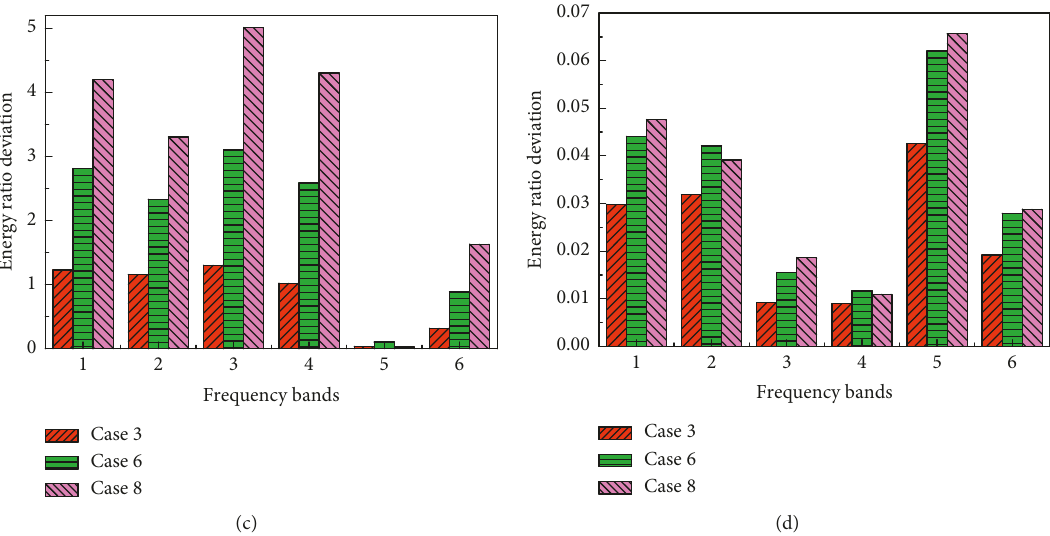
Figure 10: Hilbert damage feature vector spectrum in model tests (single damage). (a) Point 1. (b) Point 7. (c) Point 12. (d) Point